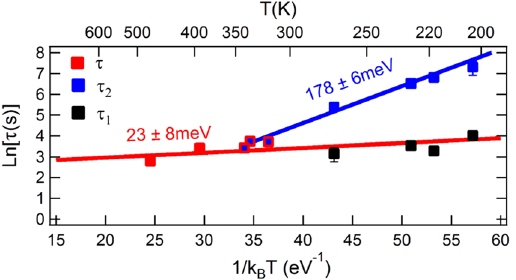
Figure 4. Arrhenius plot of the Ag-2DAG concentration relaxation time ( τ ) in the temperature range 210–470 K. Data obtained below RT require two characteristic times, τ 1 and τ 2 , to fit satisfyingly the experimental data (see text for